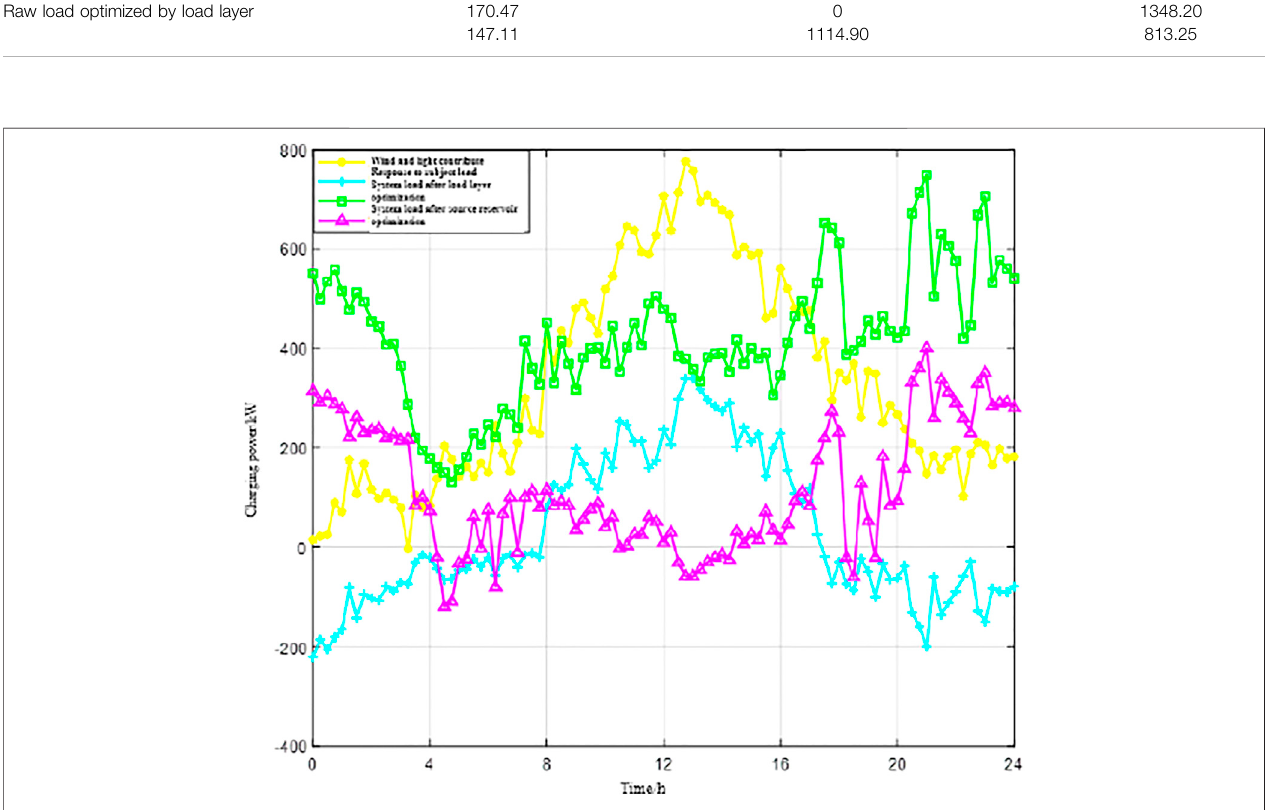
FIGURE 8 | Optimized load curve of the source reservoir.